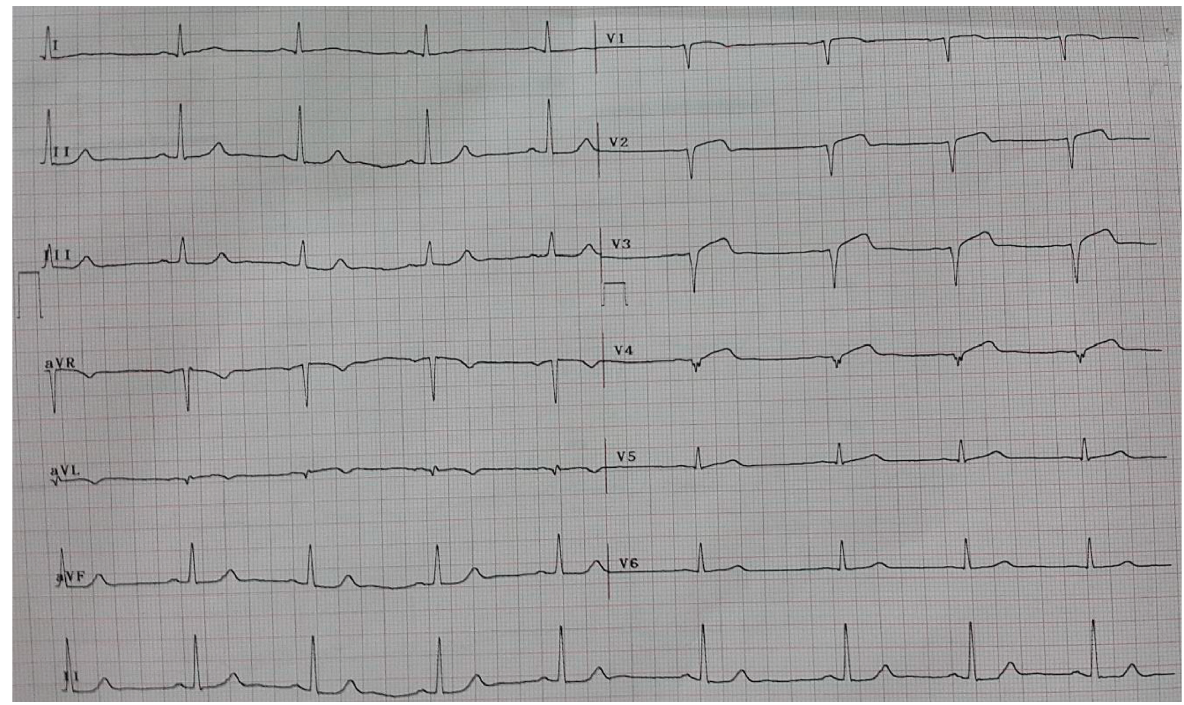
Figure 2: ECG showing progression into ST-segment elevation myocardial infarction.